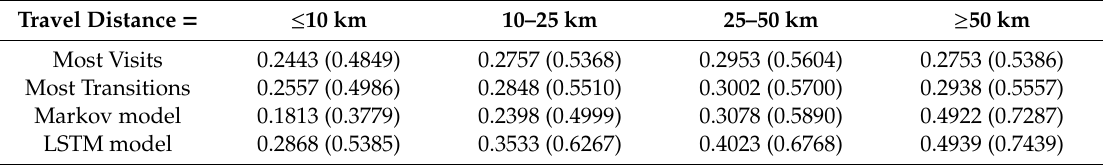
Table4. Accuracy(andaccuracyintop3inbrackets)comparisonfordi ff erentvaluesoftraveleddistance.